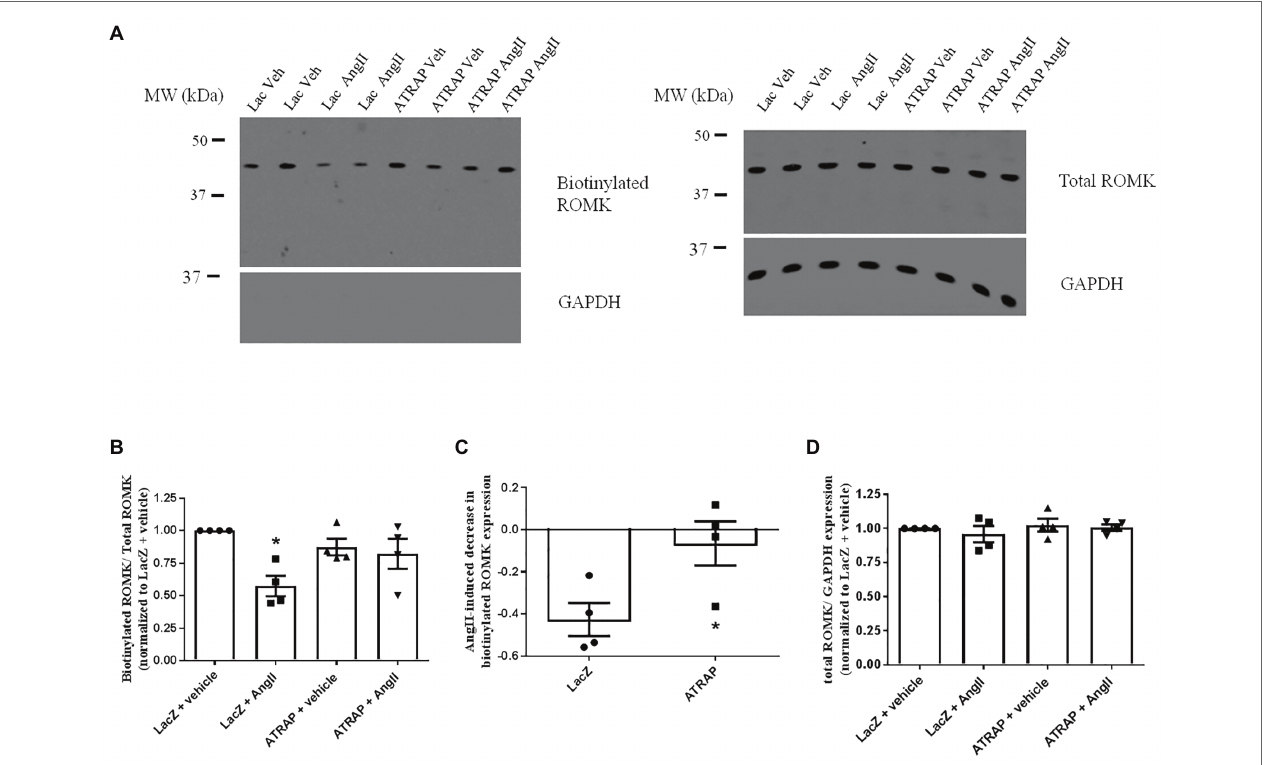
FIGURE 4 | AT1R-associated protein-overexpression blunts Ang II-mediated decrease of plasma membrane ROMK expression. M-1 cells overexpressing LacZ-V5 or ATRAP-V5 were treated with vehicle or 10 −10 M Ang II for 30–40 min before assessing plasma membrane ROMK expression by biotinylation protocol. (A) Representative immunoblot image of biotinylated ROMK, total ROMK, and GAPDH. GAPDH was also used as a control to assess purity in biotinylated samples ( Supplementary Material ). (B) Densitometry analysis of bands from biotinylated ROMK (~45-kda) normalized to total ROMK expression ( n = 4). As biotinylation protocol was performed in six-well plates, band intensities were normalized to each plate’s respective control (vehicle-treated LacZ sample). * p < 0.05 vs. vehicle-treated LacZ-overexpressing M-1 cells, using Kruskal-Wallis test followed by Dunn’s post hoc test. (C) Ang II-mediated reduction of ROMK expression at the plasma membrane in LacZ‐ and ATRAP-overexpressing M1-cells. * p < 0.05 vs. LacZ-overexpressing M-1 cells, using unpaired t -test. (D) Densitometry analysis of bands from total ROMK normalized to GAPDH expression ( n =